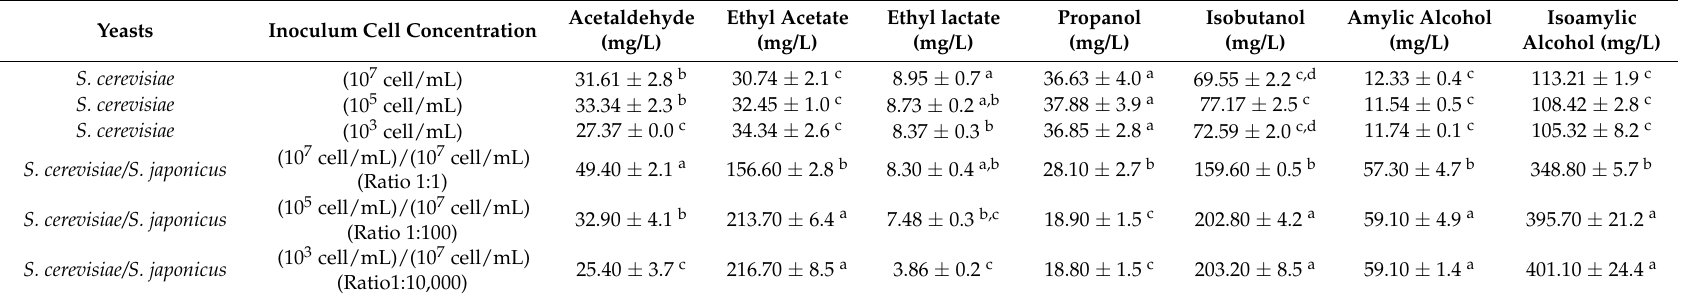
Table 2. Main byproducts of wines obtained with S. cerevisiae EC1118 in pure cultures and in mixed cultures with S. japonicus